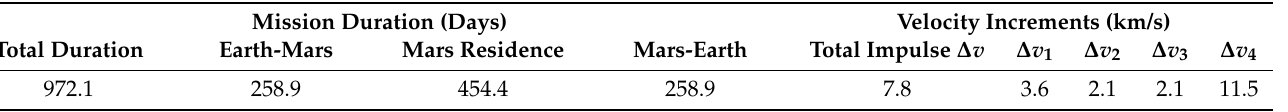
Table 1. Parameters ofthe Hohmann transfer for Earth–Mars and Mars–Earth. The velocity increments in this table are all actual ∆ v departure from